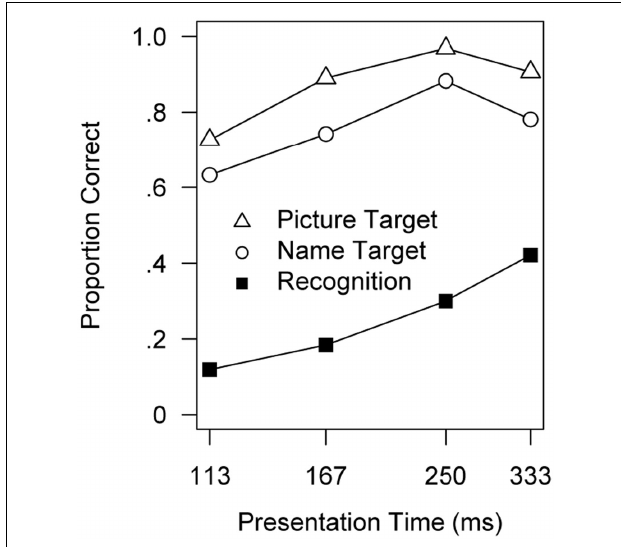
FIGURE 4 | Detection of a target picture in an RSVP sequence of 16 pictures, given a picture of the target or a name for the target, as a function of the presentation time per picture. Also shown is later recognition performance in a group that simply viewed the sequence, and then was tested for recognition. Results are corrected for guessing (see text footnote 1). From Potter (1976).